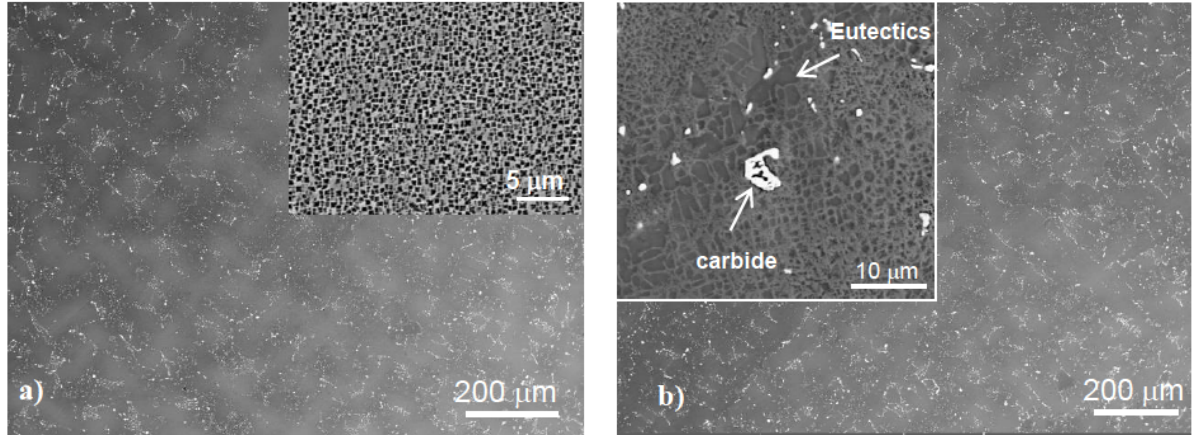
Figure 2: Microstructure of as-received state of (a) G alloy, and (b) G1 alloy.